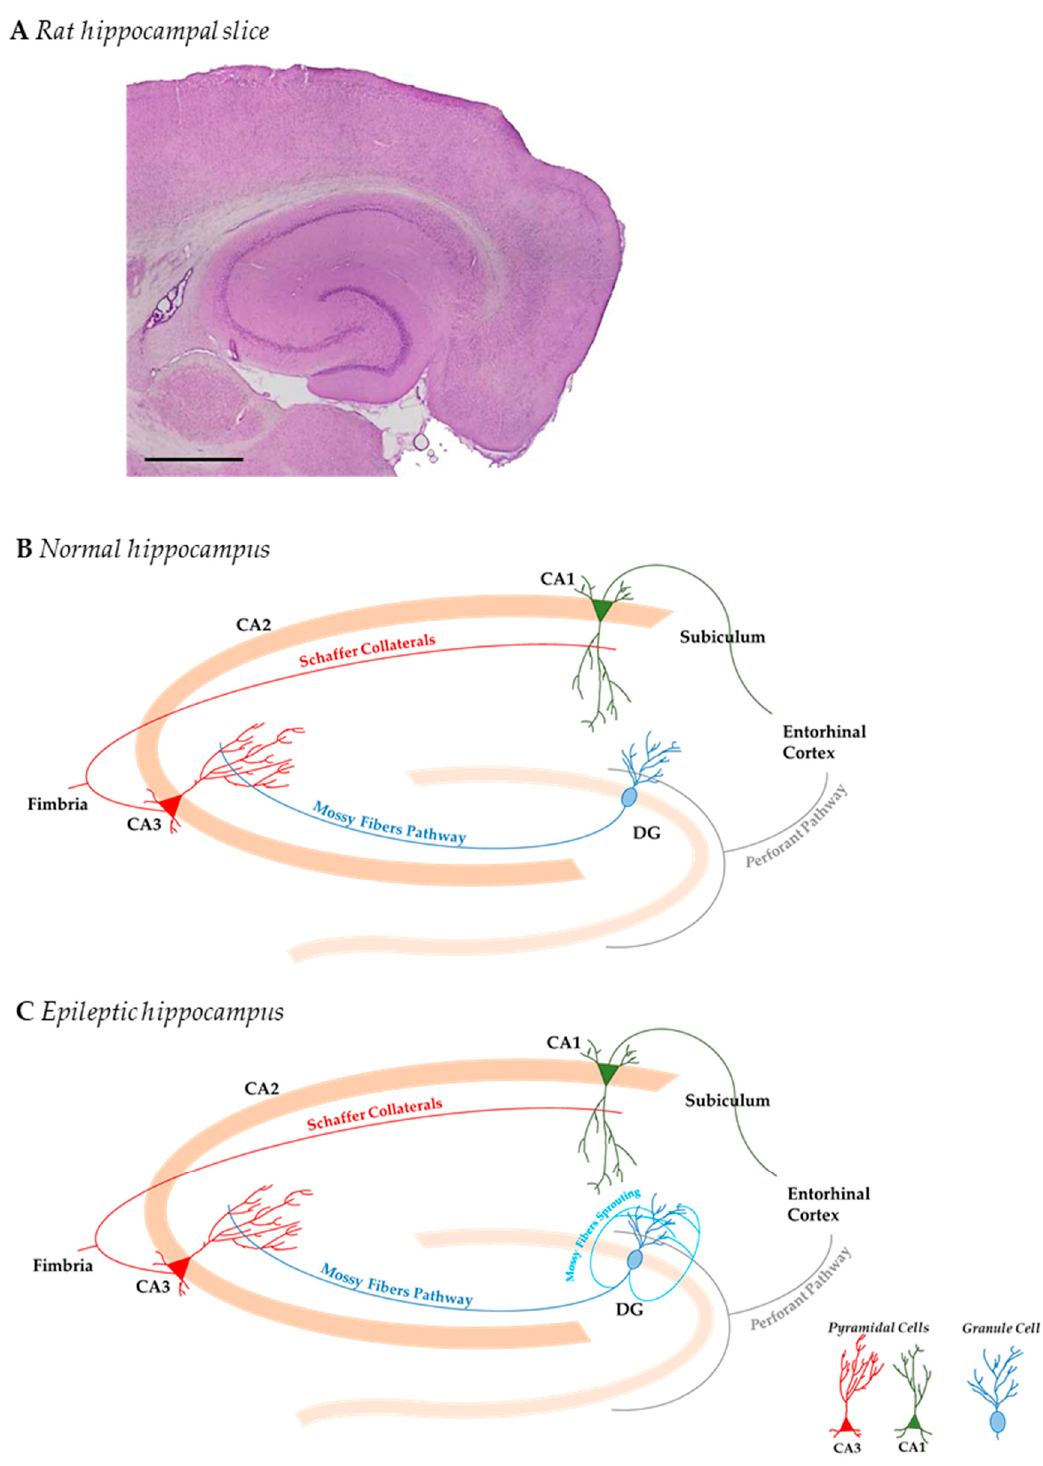
Figure 1. Graphical representation of hippocampal anatomy and connectivity in normal and epileptic temporal lobe epilepsy (TLE) brain. ( A ) Hematoxylin and eosin stained the hippocampal structure in a transverse section from an adult male rat brain (Scale bar: 1 cm). ( B ) Graphical representation of hippocampal functional circuits shows the anatomical subfields of the dentate gyrus (DG) and Cornu Ammonis (CA) areas. These hippocampal subfields are functionally inter-connected through granule mossy fibers (light blue) and Schaffer Collaterals (red) and receive major cortical input from the entorhinal cortex (perforant pathway). ( C ) The epileptic hippocampus undergoes mossy fiber sprouting, which consists of a circuit reorganization of granular cell axons (dark blue) into the dentate inner molecular layer, contributing to aberrant excitation of the hippocampal network.